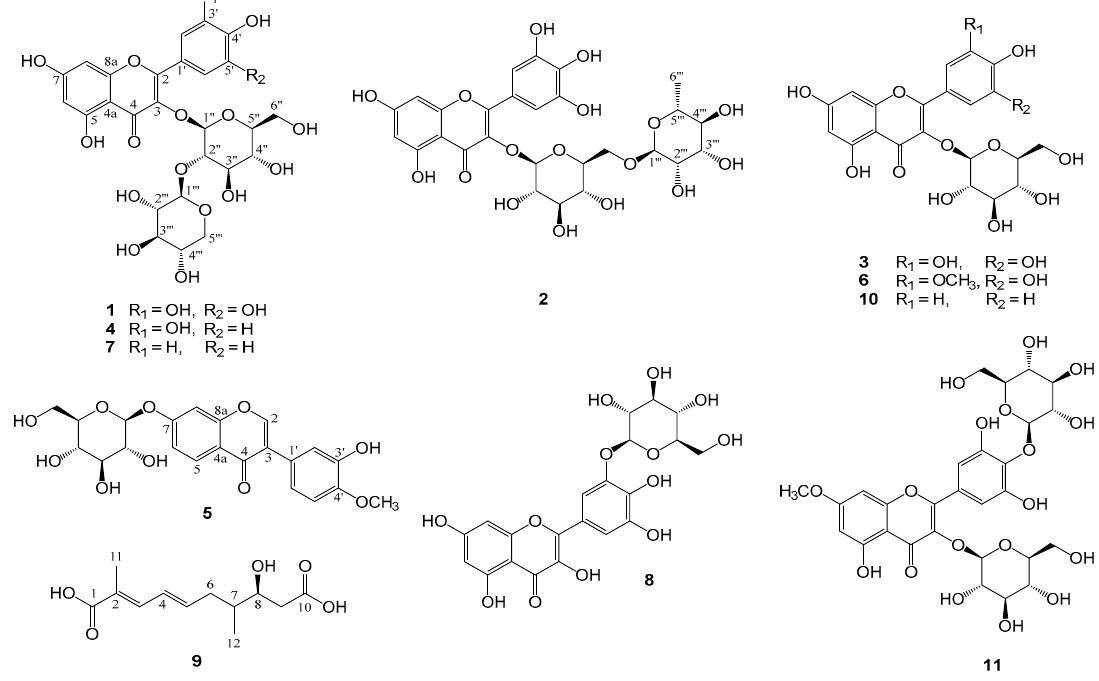
Figure 1. The chemical structures of compounds 1 – 11 isolated from Astragali Complanati Semen (ACS).